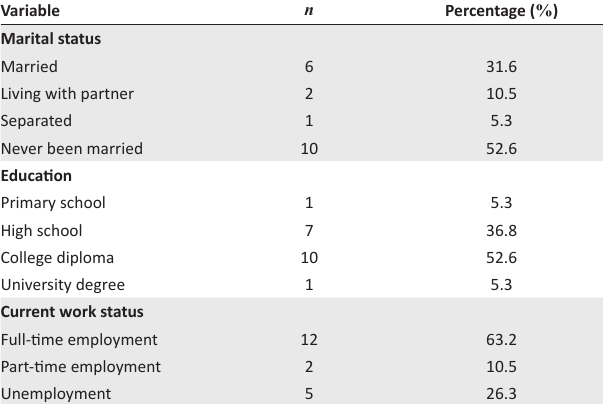
TABLE 1: Sociodemographic characteristics of the participants ( N =